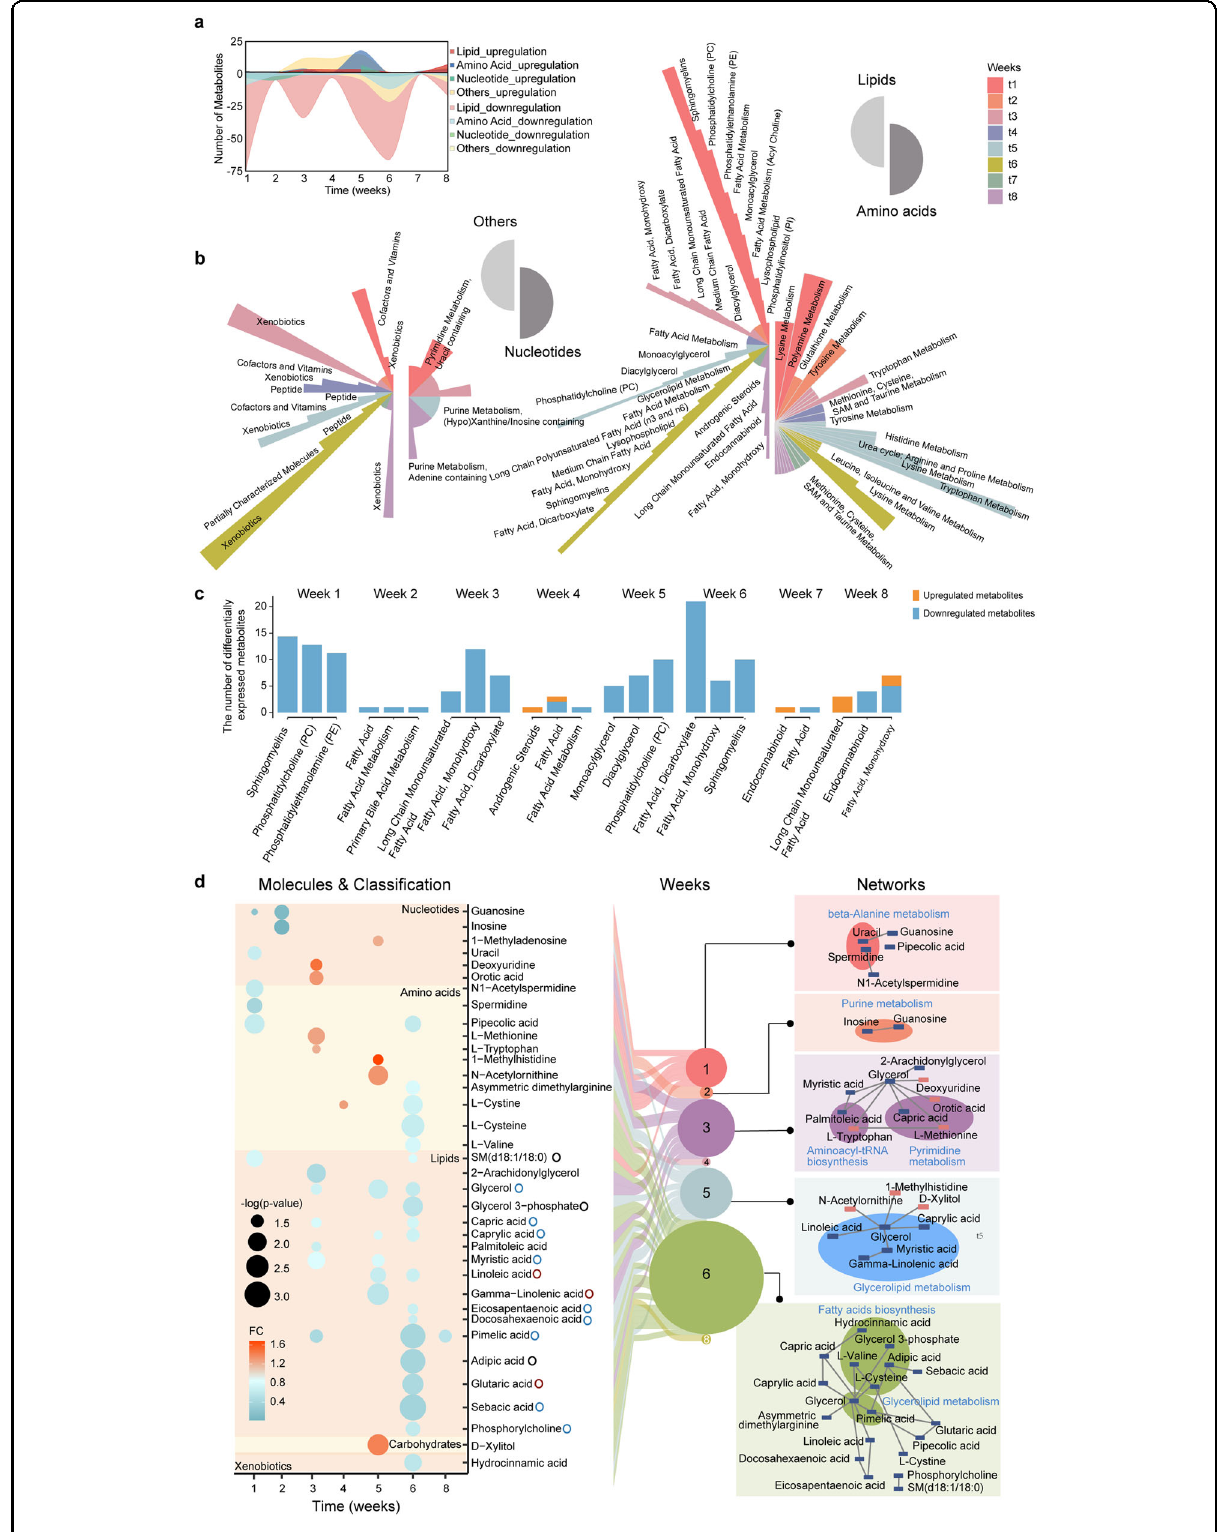
Fig. 4 (See legend on next